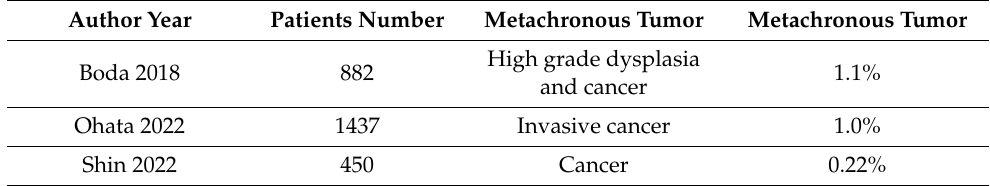
Table 5. Metachronous tumor after colorectal endoscopic submucosal dissection. Author